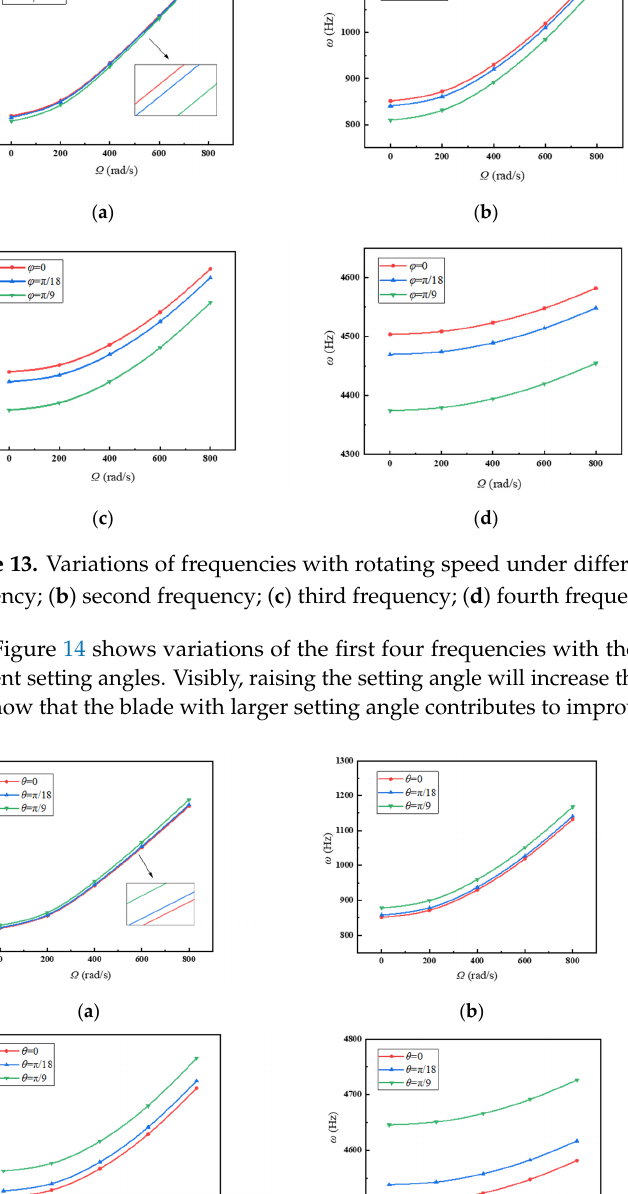
Figure 12. Variations of frequencies with rotating speed under different length-to-width ratio of the plate. ( a ) First frequency; ( b ) second frequency; ( c ) third frequency; ( d ) fourth frequency.